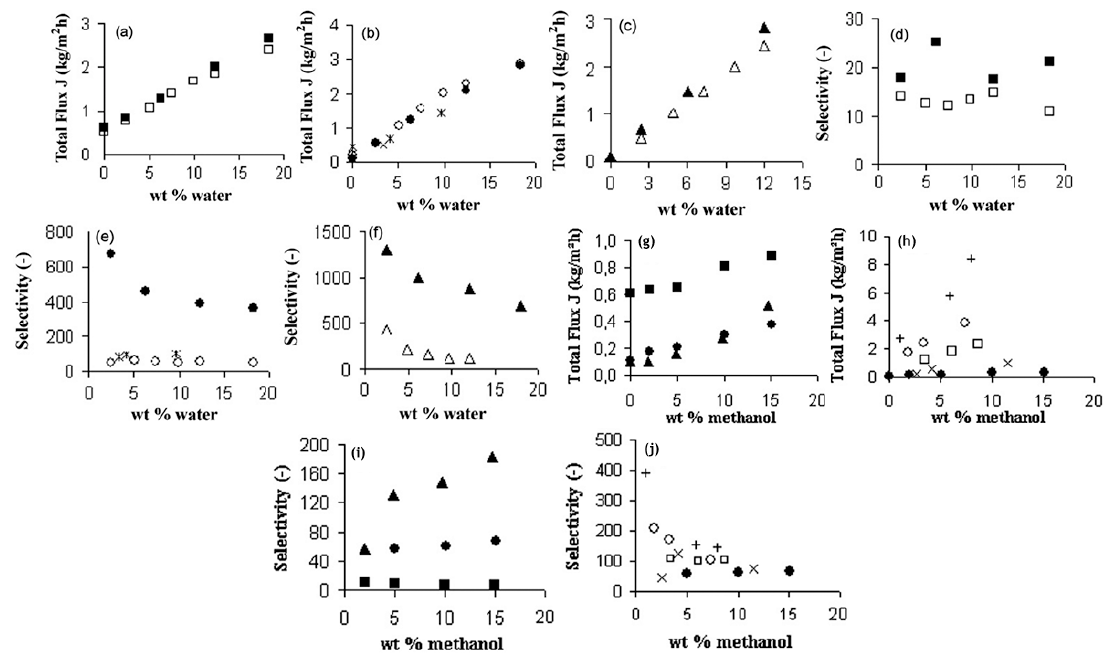
Figure 10. Mass fluxes ( a – c ) and separation factors ( d – f ) as a function of the water content (wt %) in the feed at 60 °C. Relative error = 3% ( a – c ) and 14% ( d – f ),( ■ )M1, ethanol–water, ( )M2,